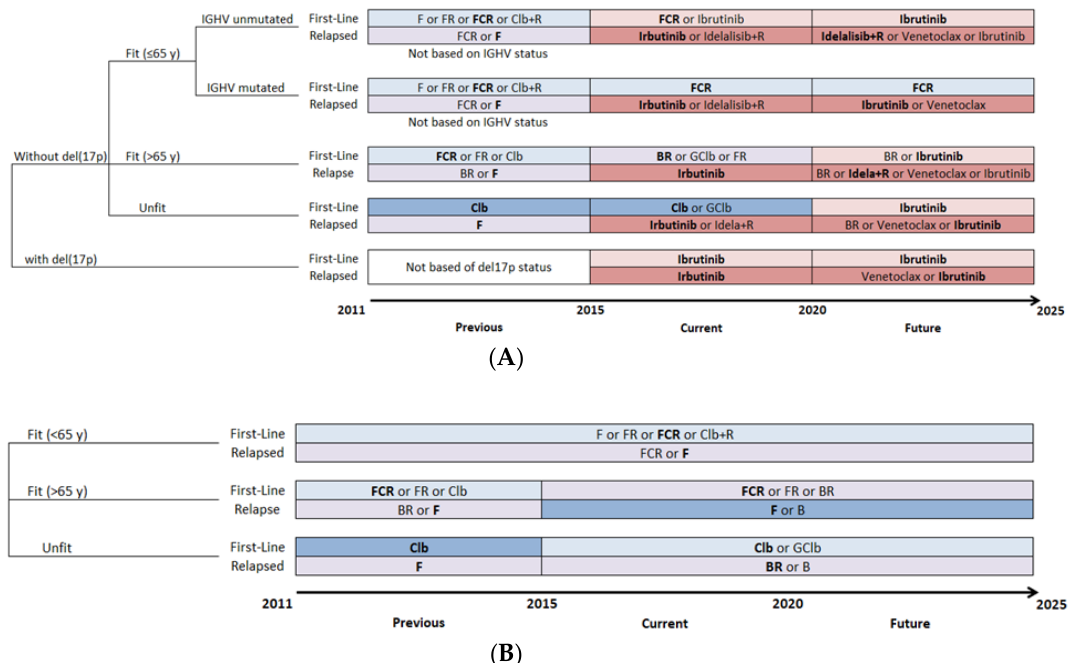
Figure 2. Management strategies for patients with CLL. ( A ) Treatment pattern of OTT scenario, with evolving therapeutic options over time. ( B ) Treatment pattern of CIT scenario, which continues the use of CIT as the standard of care through time. For the base-case analysis, the most widely used therapy was selected when more than one therapy was considered available for patients in the same condition (shown in bold). B, bendamustine; BR, bendamustine and rituximab; CIT, chemoimmunotherapy; Clb, chlorambucil; Clb + R, chlorambucil and rituximab; CLL, chronic lymphocytic leukemia; del(17p), deletion at chromosome 17p targeting the TP53 gene; F, fludarabine; FCR, fludarabine, cyclophosphamide and rituximab; FR, fludarabine and rituximab; GClb, obinutuzumab and chlorambucil; IGHV, immunoglobulin heavy-chain variable; OTT, oral targeted therapy; R, rituximab.